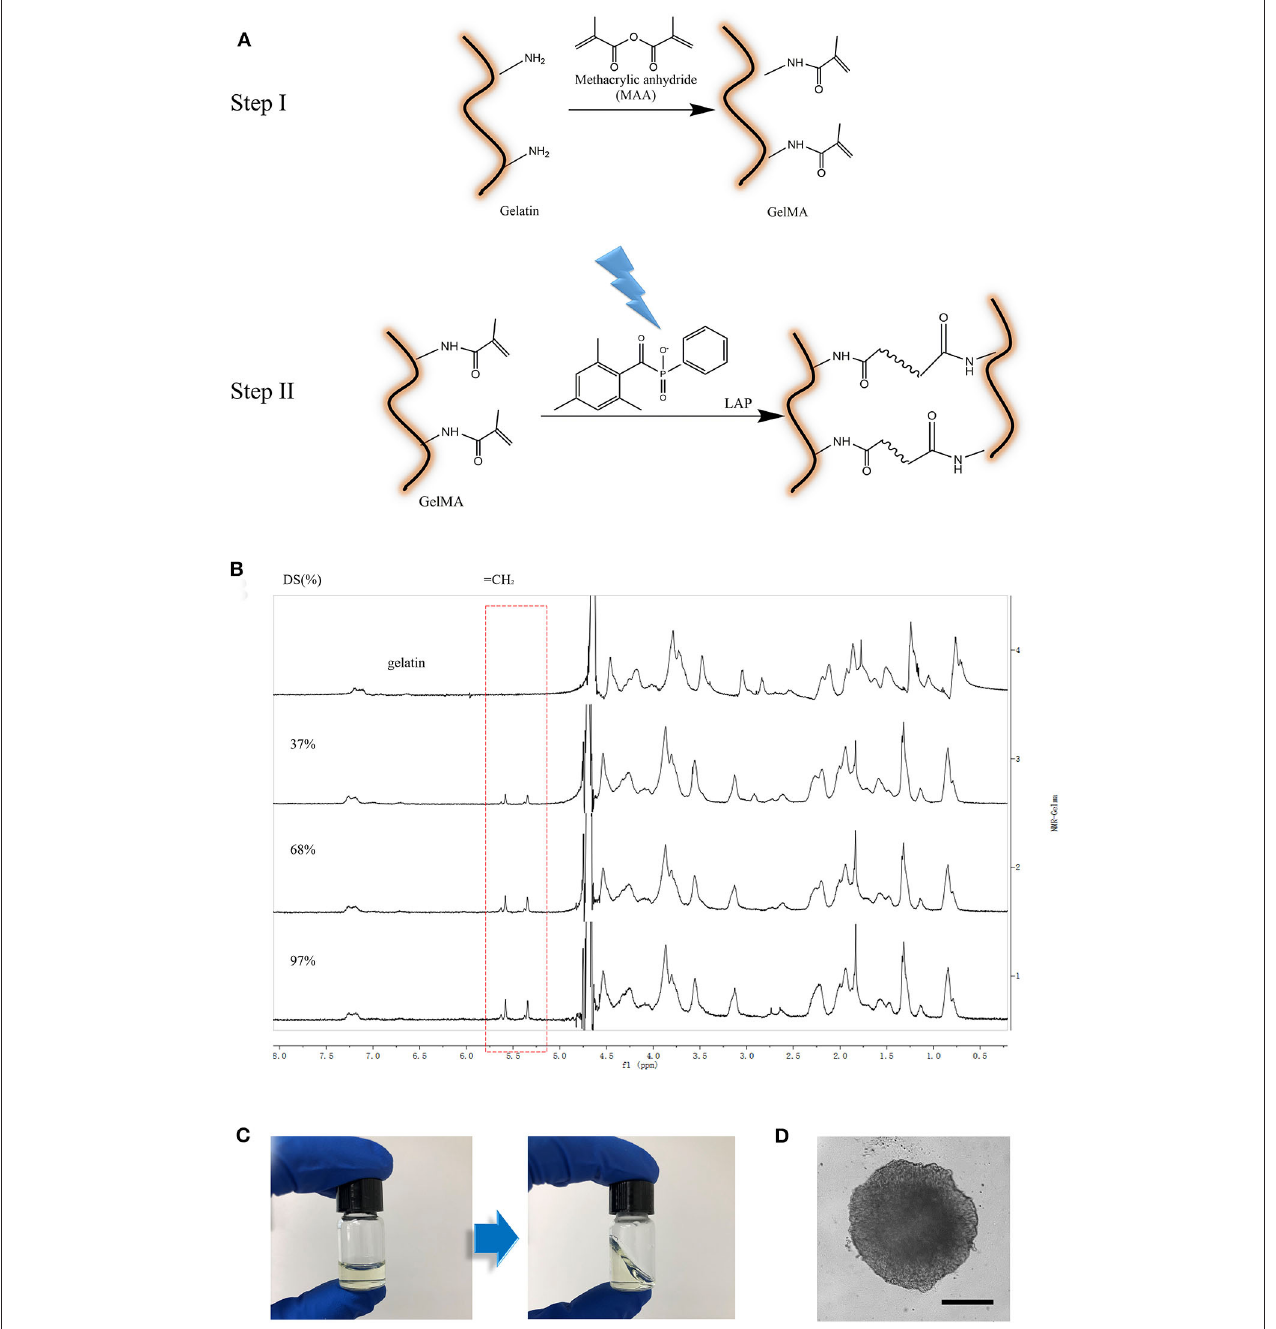
FIGURE 1 | Preparation of GelMA material. (A) Schematic illustration of GelMA reaction; (B) 1 H NMR verification of GelMA. Peak correspond to acrylic protons (2H) of methacryloylated grafts of lysine groups. (C) GelMA gelation (L-G) with 0.5% w/v LAP cross-linked with 405nm light for 1min. (D) image of 3D culturing of cancer Spheroids inside of crosslinked L-G. Scale Bar, 200 µ